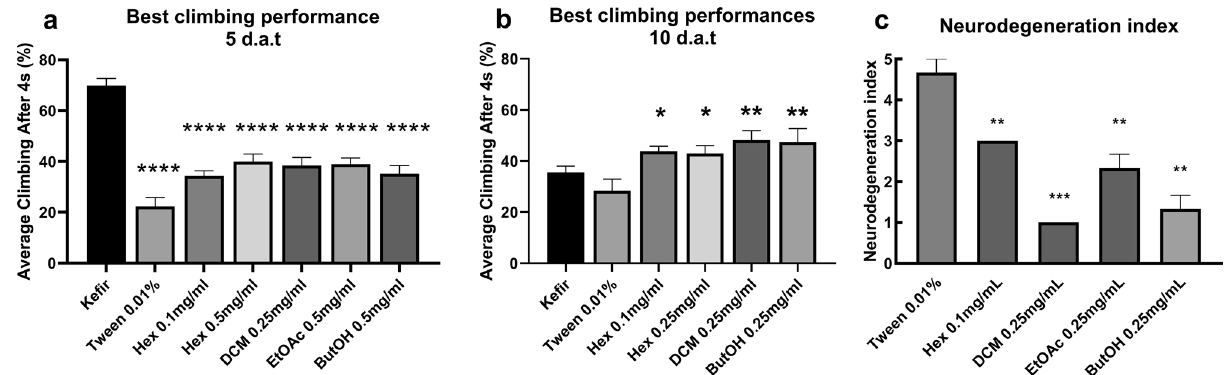
Figure 5. Average climbing ability of flies treated with best performance fractions and kefir, as well as control and vehicle after ( a ) 5 or ( b ) 10 days after treatment. Data are shown as the mean ± S.E.M. n ≥ 90 in each treatment. The statistical significance is indicated in relation to kefir group as * indicates P < 0.05, ** P < 0.01 and *** P < 0.001 (Unpaired two-tailed t-test). ( c ) Neurodegenerative index of flies treated with all four fractions 10 days after treatment, at its best performance concentration (n = 10). The statistical significance is indicated in relation to Tween 0.01% group as ** indicates P < 0.01 and *** P < 0.001 (Unpaired two-tailed